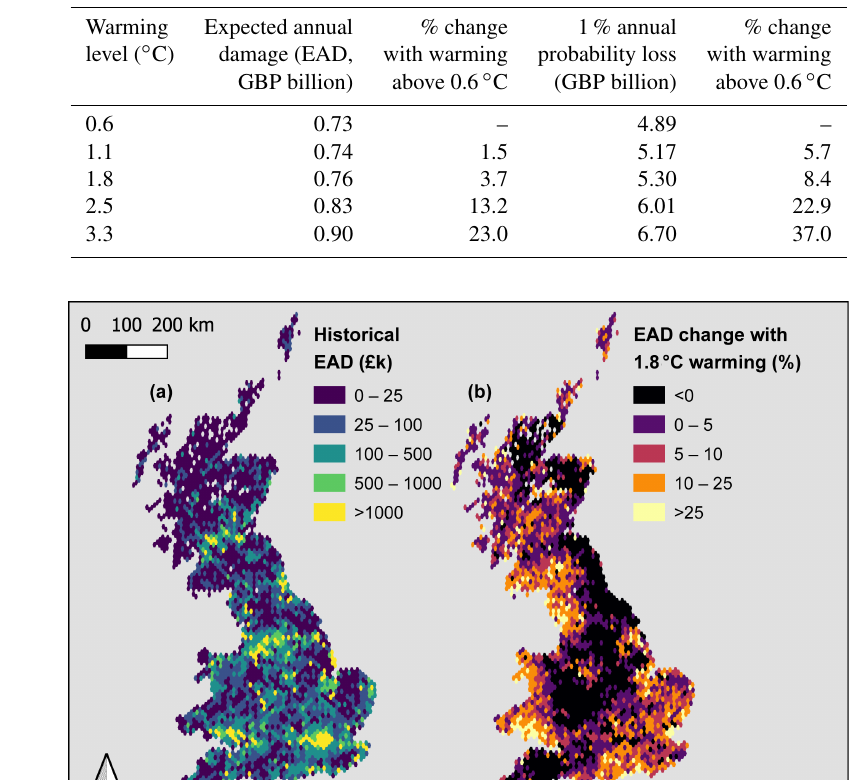
Table 4. Great Britain expected annual and 1% annual probability flood losses in GBP billion at 2020 values for different specific global warming levels since the pre-industrial (1850–1900).